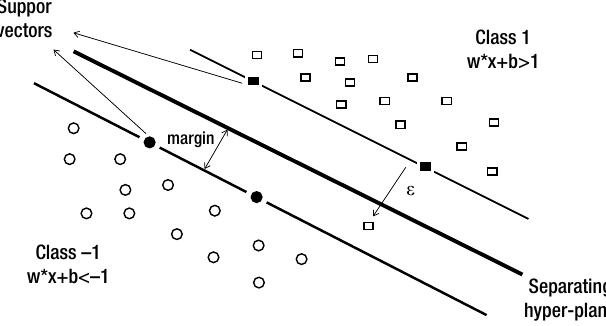
Fig. 2. Support Vector